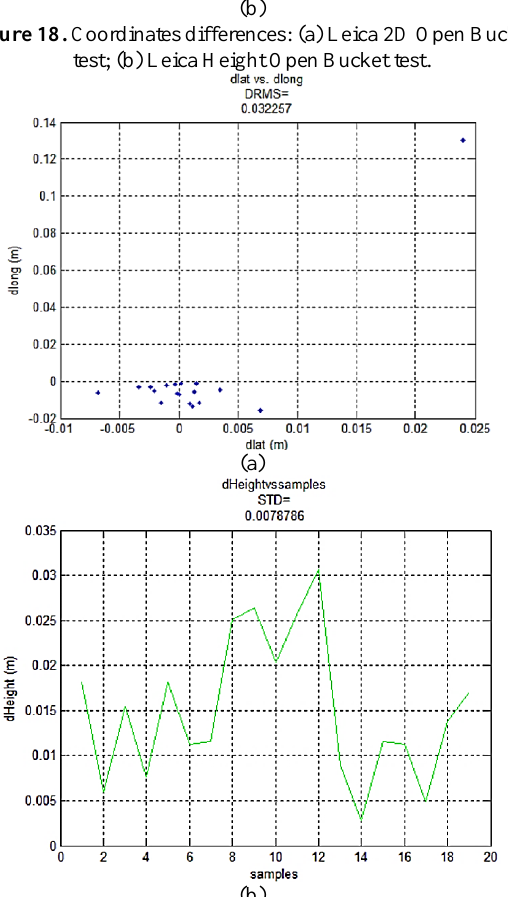
Figure 19. Coordinates differences: (a) Javad 2D Open Bucket test; (b) Javad Height Open Bucket test.